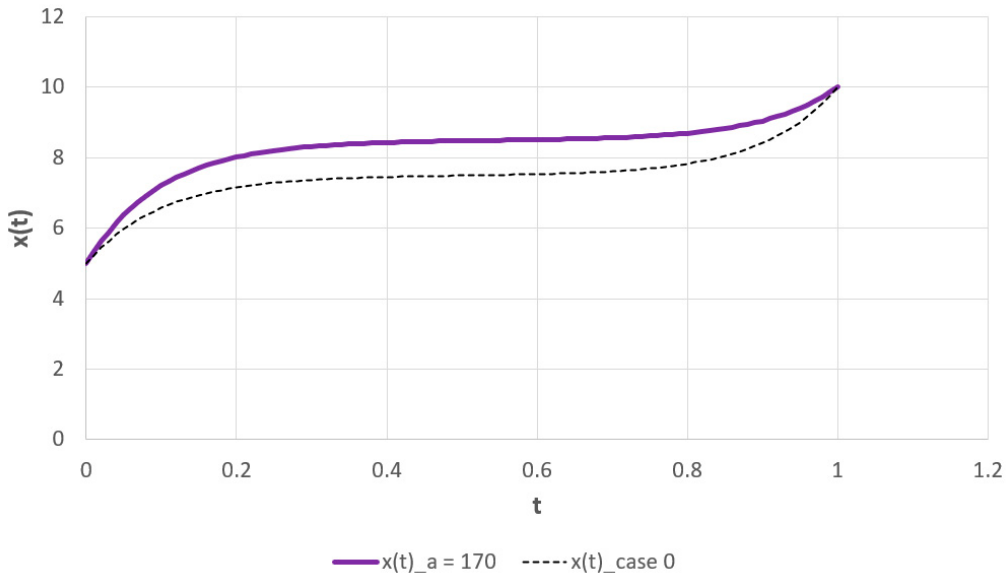
Figure 14. The optimal time path of x in Dynamic case 2.